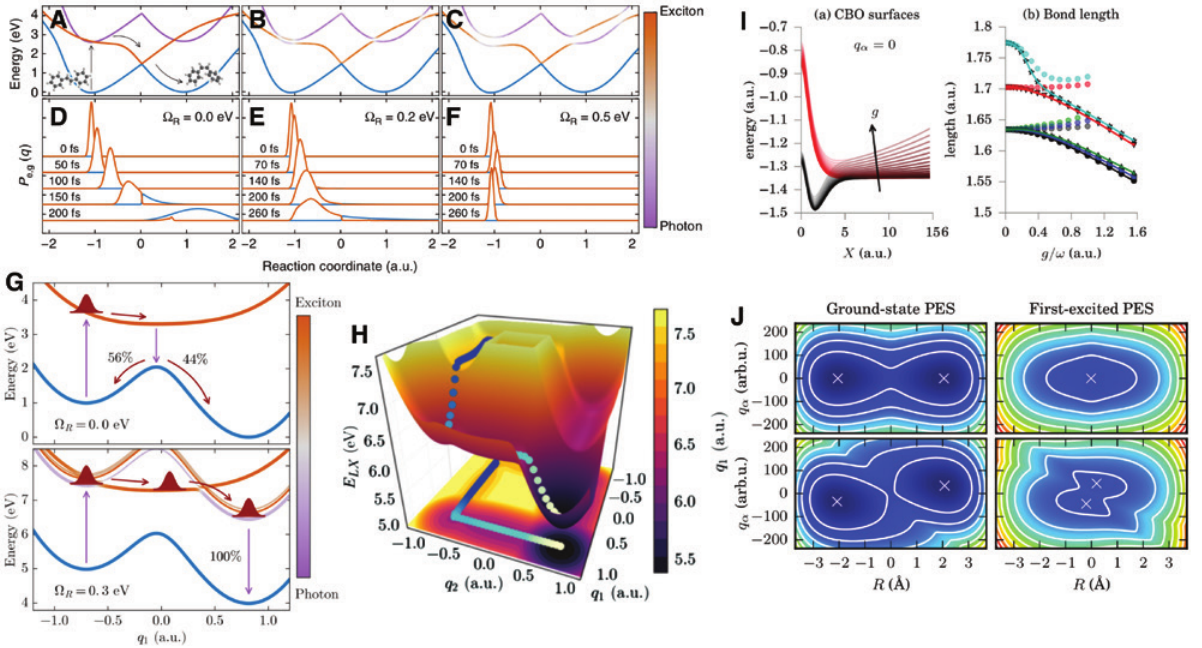
Figure 5: Photochemical reactions under strong light-matter coupling. (A–C) Suppression of photoisomerization under strong coupling for single molecules [134] with modification of the potential energy surfaces. (D–F) The polaritonic surfaces introduce a energy gap that traps the initially excited-state wave packet. (G) Reaction quantum yield for reaching either the stable (44%) or the metastable (56%) configuration in the electronic ground state can be largely increased in the strong coupling limit [142]. (H) Many-molecule reactions triggered by single photon [142]. (I) Potential energy surfaces in CBOA [50] for a 1D model (a) and changes of the bond length of a hydrogen dimer (b). (J) 2D CBOA potential energy surfaces in weak (top) and strong (bottom) coupling [50]. (A–F) Adapted with permission from Ref. [134]. (G and H) Adapted with permission from Ref. [142] (© 2017 American Physical Society). (I–J) Adapted with permission from Ref.